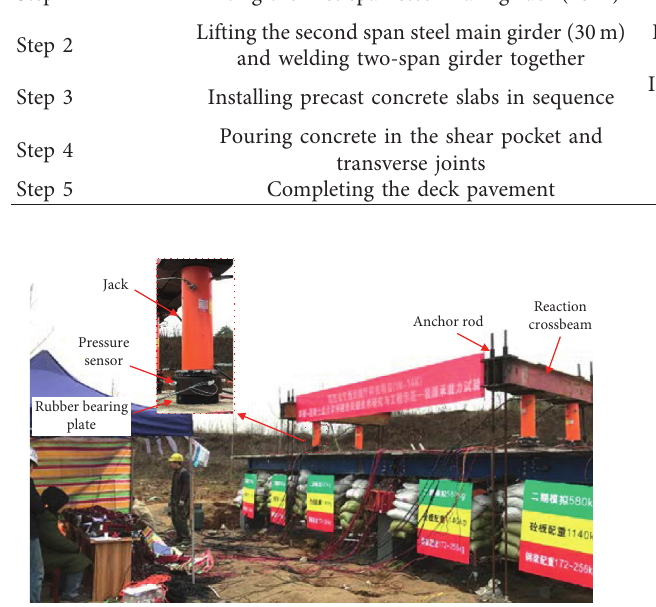
Figure 4: Overview of the test